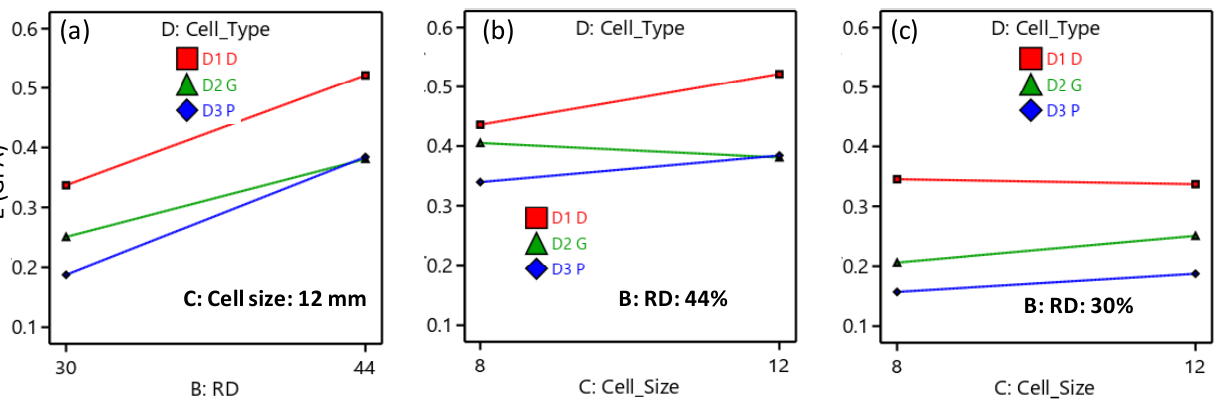
Figure 10. Interaction plots: ( a ) BD interaction, ( b ) CD interaction, and ( b . c ) BCD interaction.